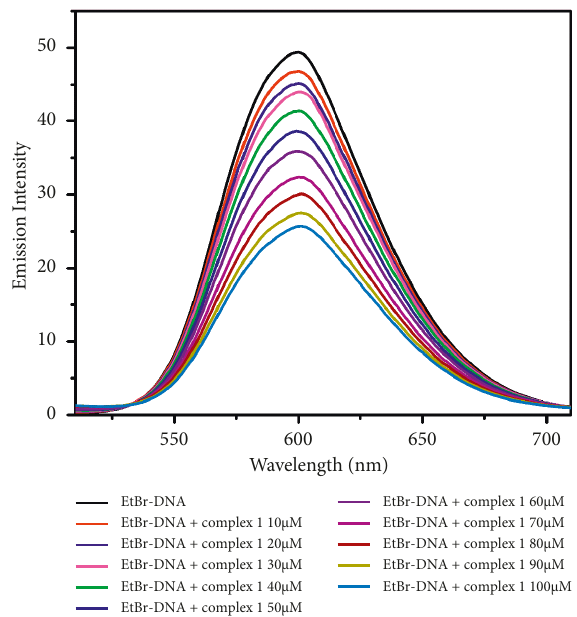
Figure 6: Fluorescence spectra of EtBr bound to DNA with in- creasing amounts of complex 1 (0–100 µ M).